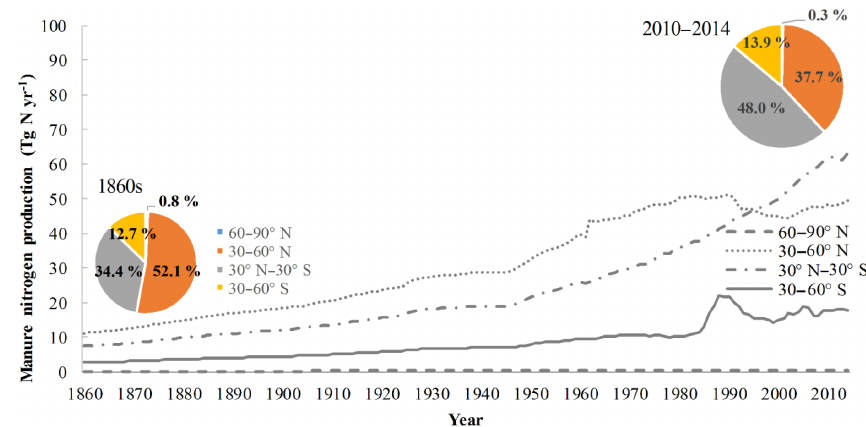
Figure 3. Estimation of global manure nitrogen production in northern high latitudes (60–90 ◦ N), northern midlatitudes (30–60 ◦ N), tropical regions (30 ◦ N–30 ◦ S), and southern midlatitudes (30–60 ◦